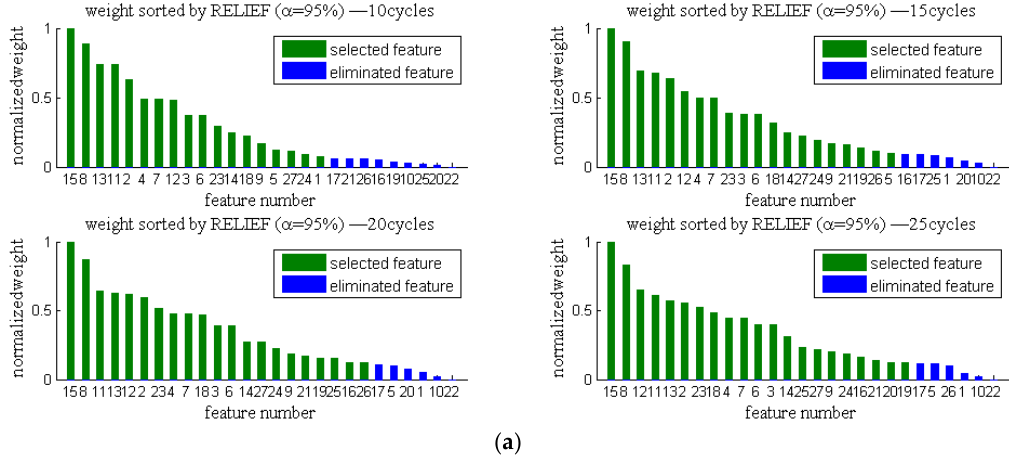
Figure 5. Cont . Figure 5.